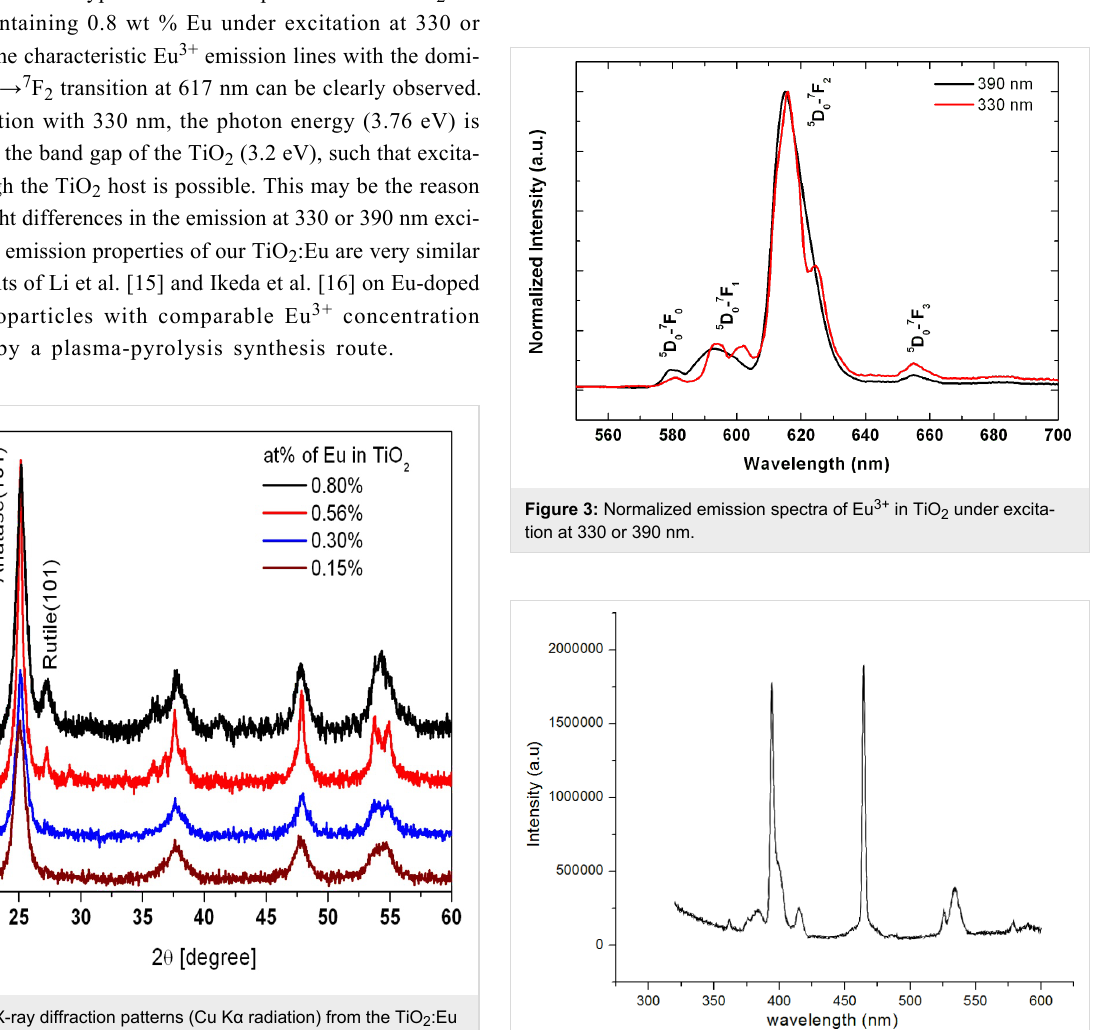
Figure 4: Excitation spectrum of TiO 2 :Eu nanoparticles detected at 617 nm